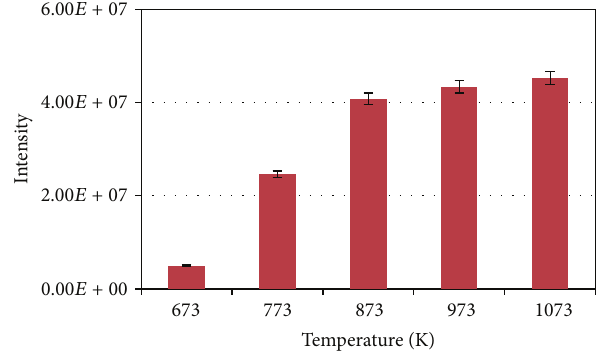
Figure 3: The gas production from pyrolysis of biomass.